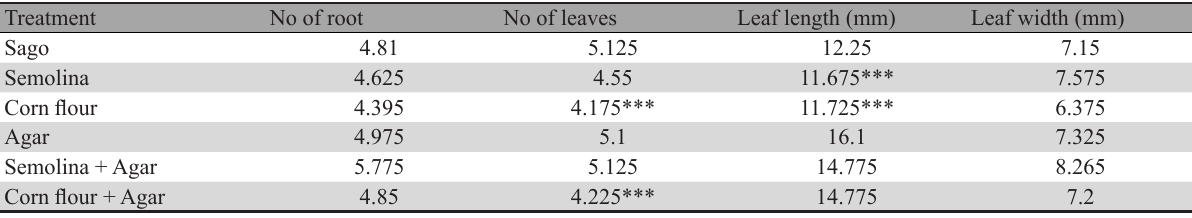
Table 4. Effect of different gelling agent on growth parameters in MS media Treatment